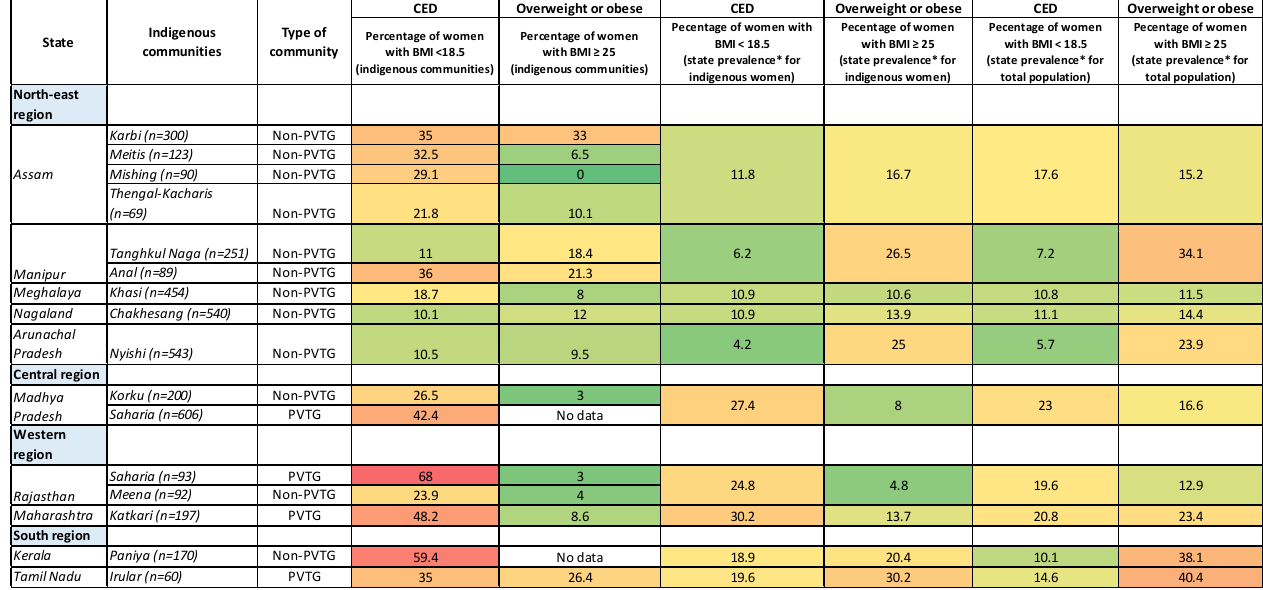
( b ): Heat map depicting the prevalence of chronic energy deficiency and overweight/obese in indigenous women from north-east, central, western and southern regions of India. Figure 4. ( a , b ) Heat map depicting the prevalence of chronic energy deficiency and overweight/obese in indigenous women from selected states of India. Note: Red shading indicates a high prevalence (>40%) of chronic energy deficiency or overweight/obese, with darker shades representing a higher prevalence. Orange shading represents a moderate prevalence of 29–39%; Yellow shading represents a prevalence of 16–28%, with green yellowish shades representing a lower prevalence. Green shading represents a low prevalence (<16%), with darker shades representing a lower prevalence. * NFHS-5 (2022) [20]